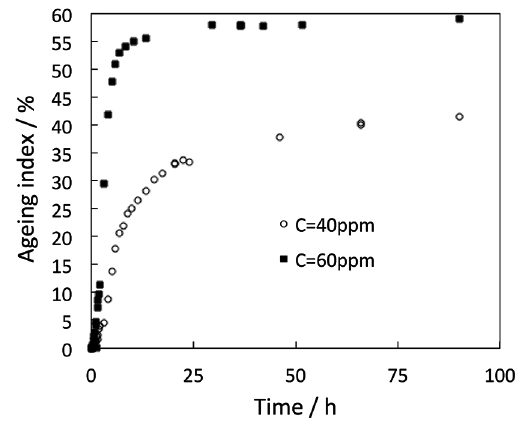
Figure 1. Behaviour of the ageing index as a function of time for samples with 40ppm and 60ppm C aged at 200 and 225°C, respectively.